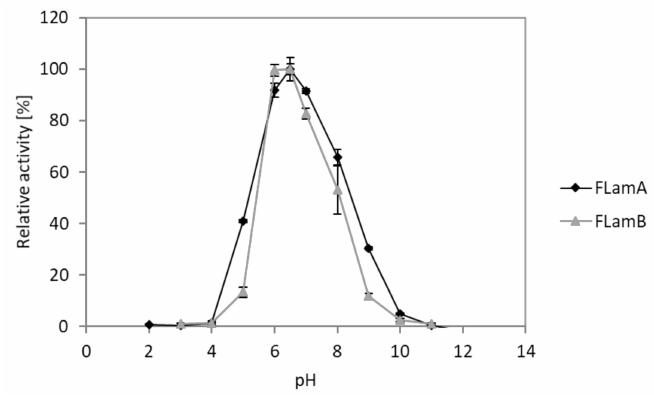
Figure 6. Influence of pH on the activity of recombinant FLamA and FLamB towards